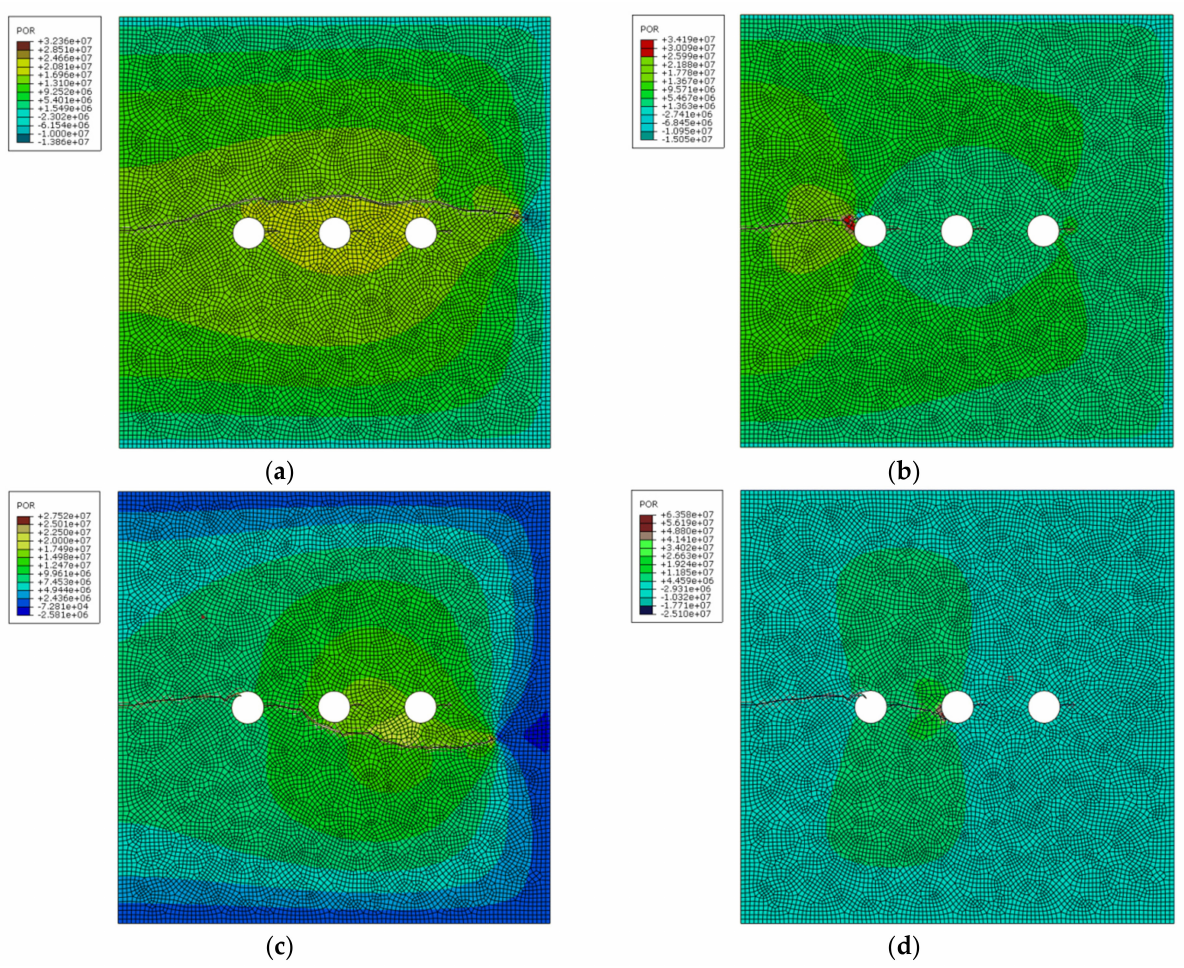
Figure 16. Schematic diagram of fracture propagation under different horizontal stress differences: ( a ) ∆ σ = 5 MPa; ( b ) ∆ σ = 10 MPa; ( c ) ∆ σ = 15 MPa; and ( d ) ∆ σ = 20 MPa. (POR is the pore pressure. With the color gradually changing from red to blue, the pore pressure